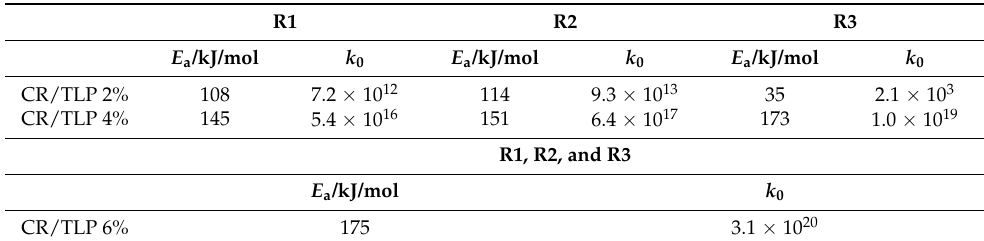
Reaction 1 (R1), Reaction 2 (R2) and Reaction 3